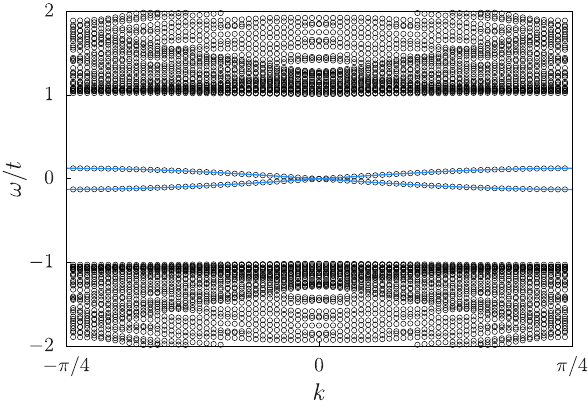
FIG. 10. Spectrum of eigenvalues of the Kane-Mele model with a periodic chain of (cid:1) fluxes (cf. Fig. 9). Here, (cid:4)=t ¼ 0 : 2 , (cid:5) ¼ 0 , and the honeycomb lattice has dimensions 72 (cid:4) 12 . Points correspond to eigenvalues and lines to the band structure (cid:13) ð k Þ ¼ (cid:1) 2~ t sin ð 2 ka Þ , with ~ t (cid:6) 0 : 126 t and a (cid:10) 1